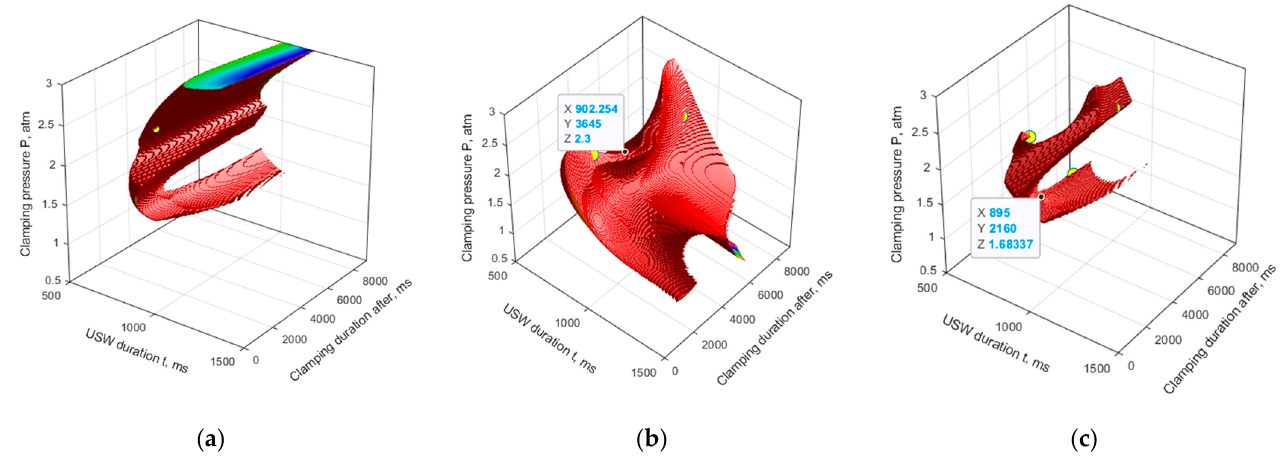
the experimental parameters;The USW parameters used in the the param-